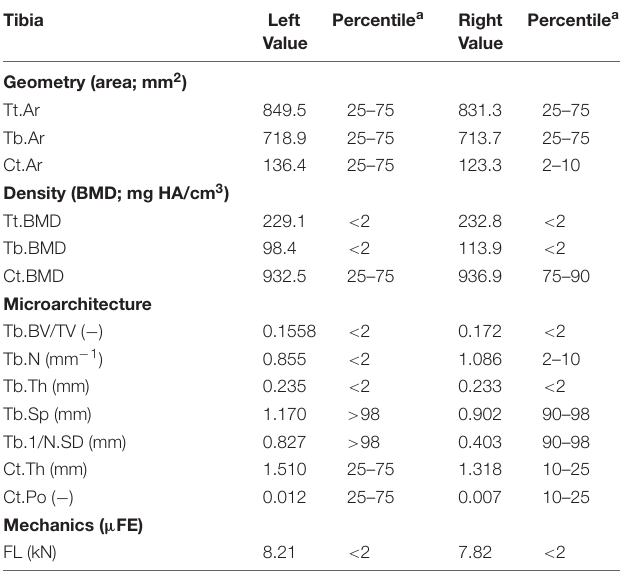
TABLE 2 | Bone parameters of the left and right distal tibia of patient 2, a 23-year-old man including normative values of the distal radius of age- and gender-matched controls.